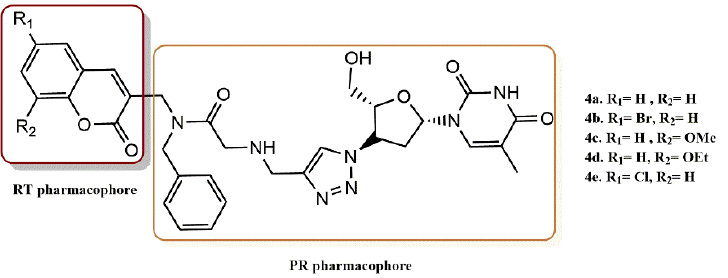
Figure 6. RT and PR pharmacophores of new active synthesized compounds 4a-e